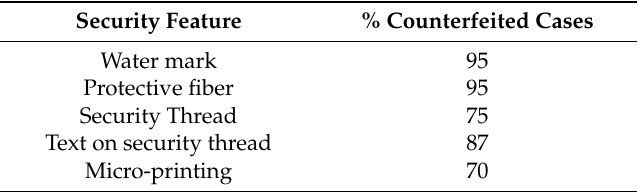
Table 1. Analysis report by central bank of Russia on counterfeited features.